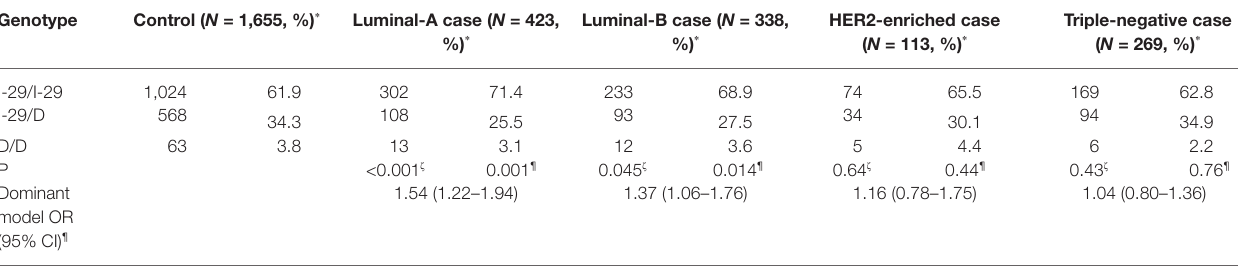
TABLE 3 | Association between genotypes of NQO2 tri-allelic polymorphism and risk of breast cancer subtypes. Genotype Control ( N = 1,655, %) * Luminal-A case ( N = 423,